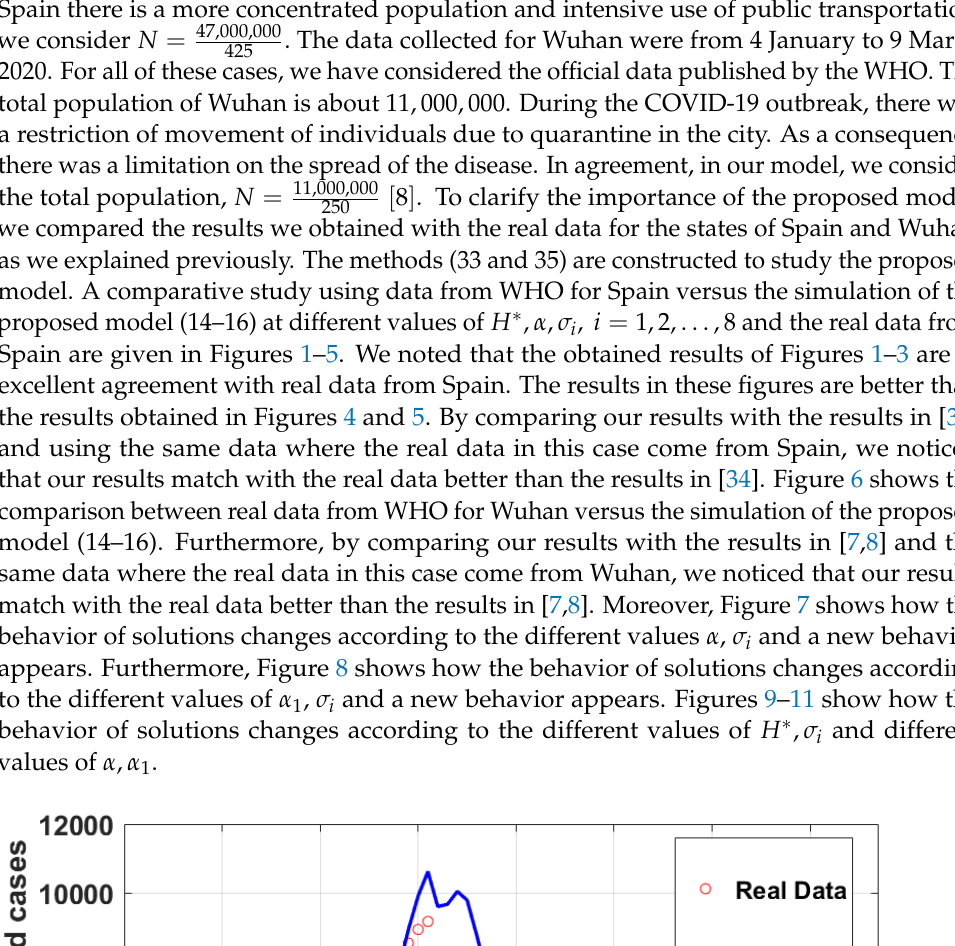
Figure 2. Numerical simulation for system (14 – 16) at 𝐻 ∗ = 0.6, 𝛼 = 0.9, 𝛼 1 = 0.87 , 𝜎 1 = 𝜎 2 = 𝜎 3 = 0.01 , 𝜎 4 = 𝜎 5 = 𝜎 6 = 𝜎 7 = 𝜎 8 = 0.1 .